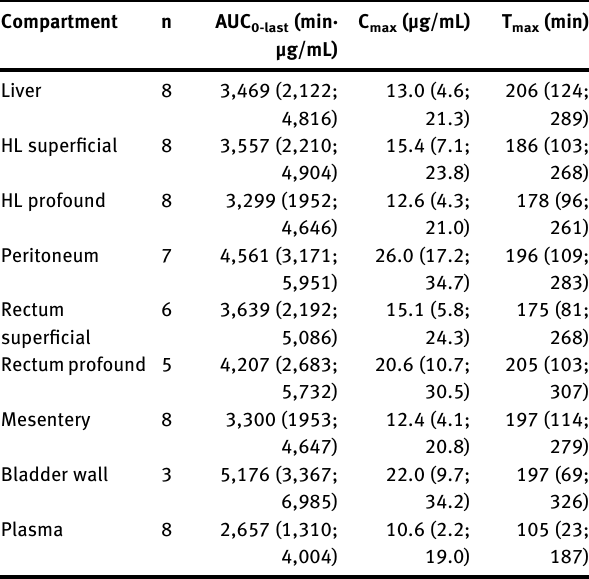
Table  : Pharmacokinetic data for carboplatin given as mean (  % con fi dence interval) for all